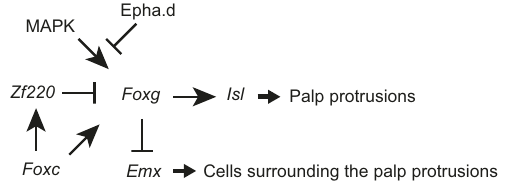
Fig. 9 Foxg plays a central role in patterning the ANB. The gene regulatory circuit in the ANB revealed by the present and previous studies